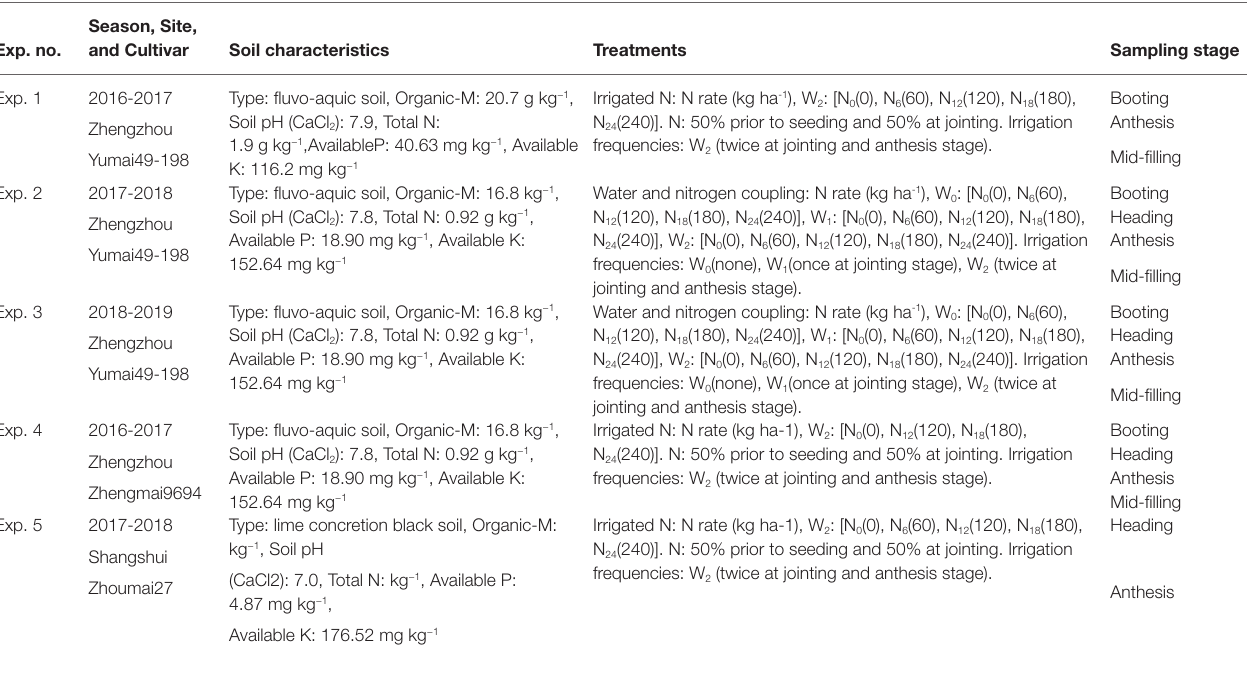
TABLE 1 | Seasons, soil status, cultivars, nitrogen rates, irrigation frequency, and sampling dates for five experiments.